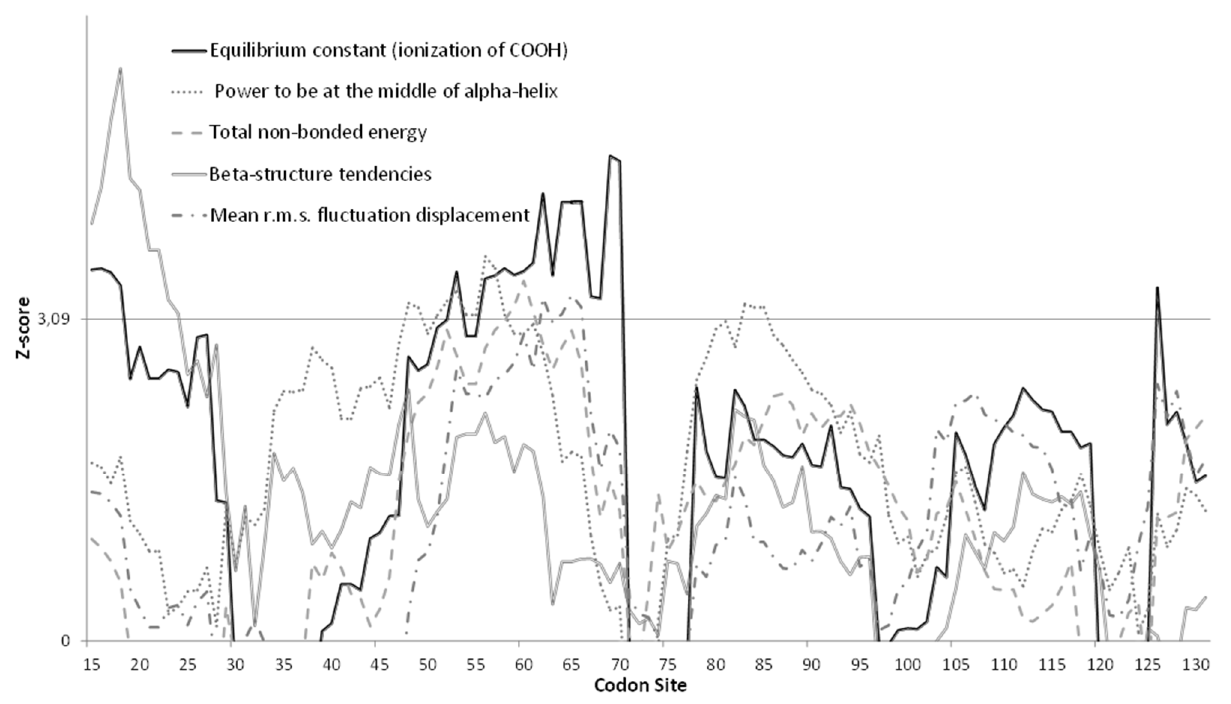
Figure 4. Results of the TreeSAAP sliding analysis with a window width of 15 residues of the VP1 amino acid sequences (see also Table 1). The X -axis indicates the last codon of the window. The Y -axis corresponds to the Z-score values for the five properties that reach the threshold of 3.09 [54]. Biochemical properties affected by stabilizing selection (categories 1–3) are shown in grey with dashed lines; the one affected by destabilizing selection (categories 6–8) in black.